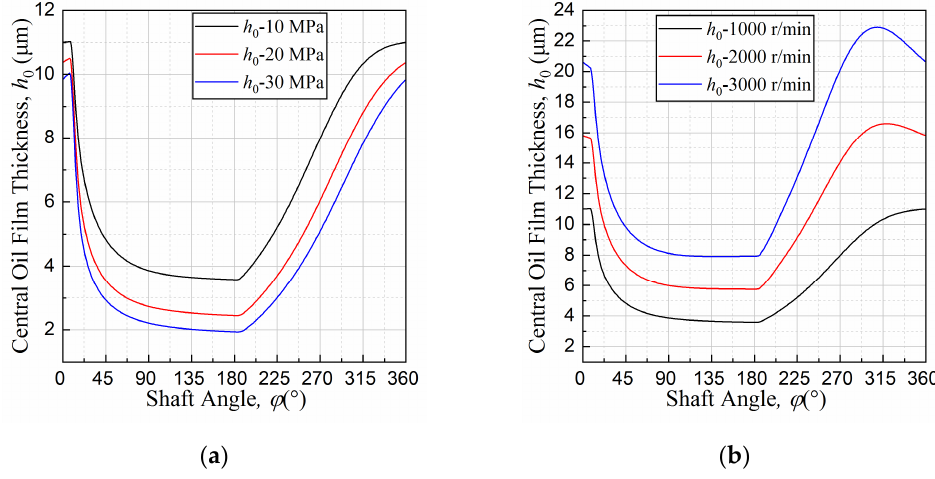
Figure 11. Central oil film thickness under different working pressure and shaft speed, where ( a ) is under different working pressure at shaft speed of 1500 r/min; ( b ) is under different shaft speed at working pressure of 10 MPa.